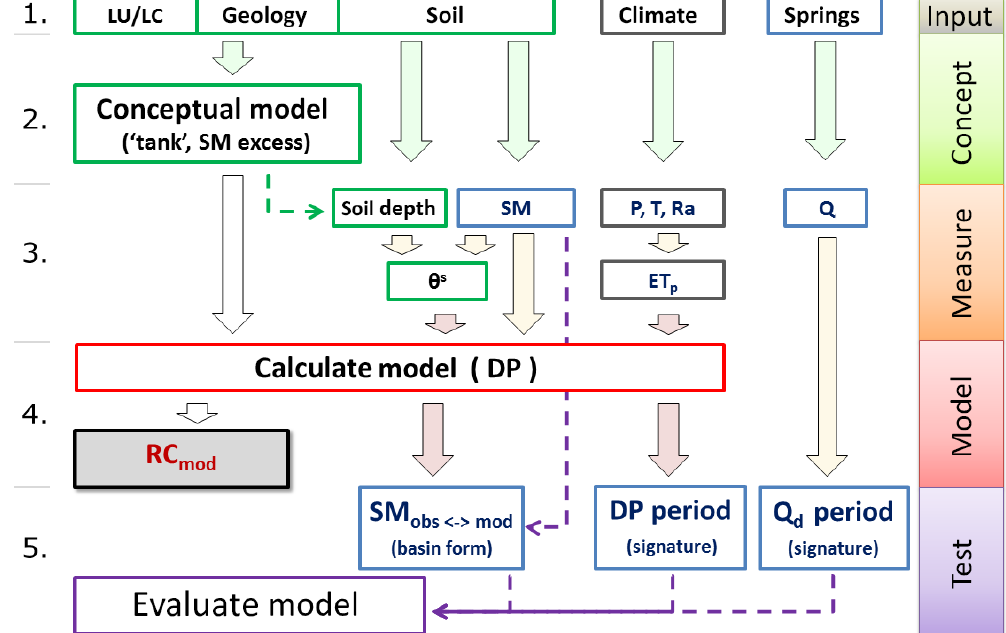
Figure 3. Conceptual flow chart of the work steps for the model. First row: measured and observed input such as climate, spring flow, land use and land cover (LU/LC), etc. Second row: conceptualisation of the one-reservoir tank model. Third row: actual measurements of daily values for soil moisture (SM), precipitation ( P ), temperature ( T ), solar radiation (Ra), spring flow ( Q ), etc.. Fourth row: modelling of deep percolation (DP) and transformation into annual recharge coefficients for each of the modelled formations (RC mod ). Last row: model evaluation by different tests such as quantitative comparison between observed and modelled soil moisture contents (SM obs and SM mod ) and semi-qualitative comparison between periods of percolation events and peak discharge at the daily measured springs.